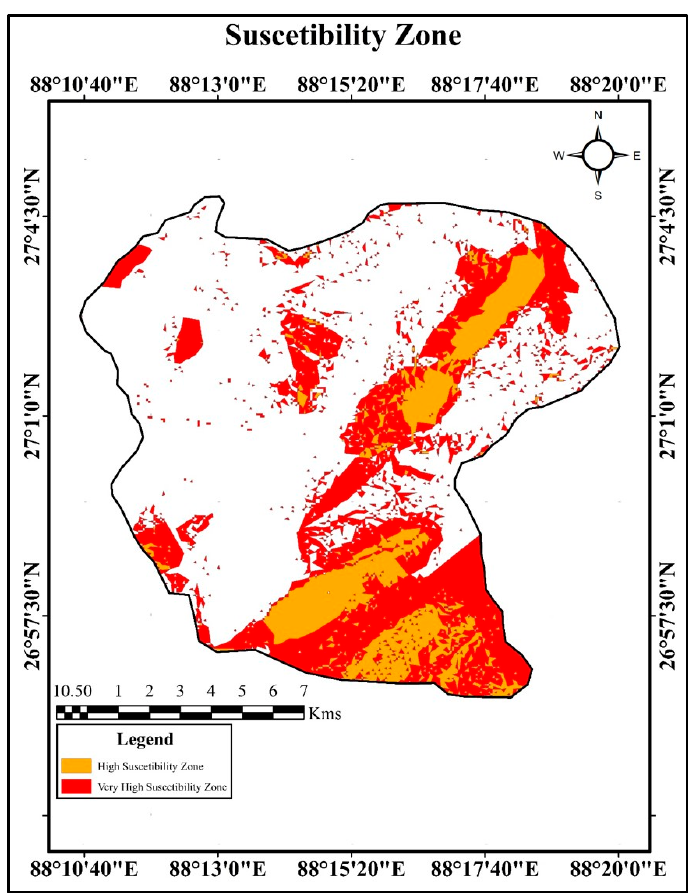
Figure 10. The map shows the high to very high susceptibility zone of the study